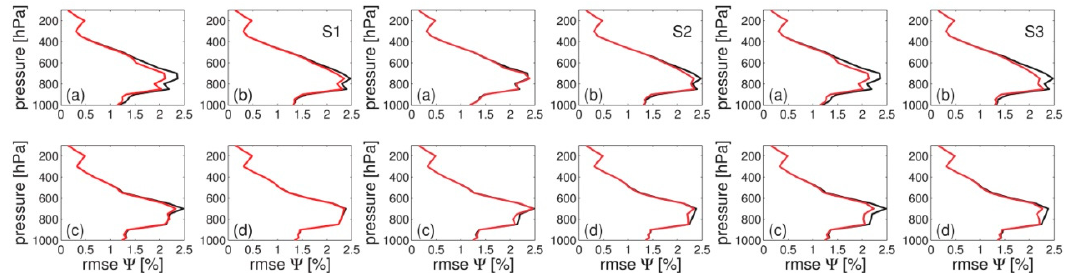
Figure 5. The root mean square error of the background (analysis) refractivity in percent as a function of the pressure in black (red). Left panel: ZTDs are assimilated. Middle panel: horizontal delay gradients are assimilated. Right panel: ZTDs and Horizontal delay gradients are assimilated. In each panel the four plots correspond to the grid points surrounding the station Potsdam. The labels (a), (b), (c) and (d) correspond to the grid points to the north-west, north-east, south-west and south-east respectively. Data from the single station Potsdam are assimilated four times per day (0, 6, 12, 18 UTC) for a period of two months (June and July, 2017).